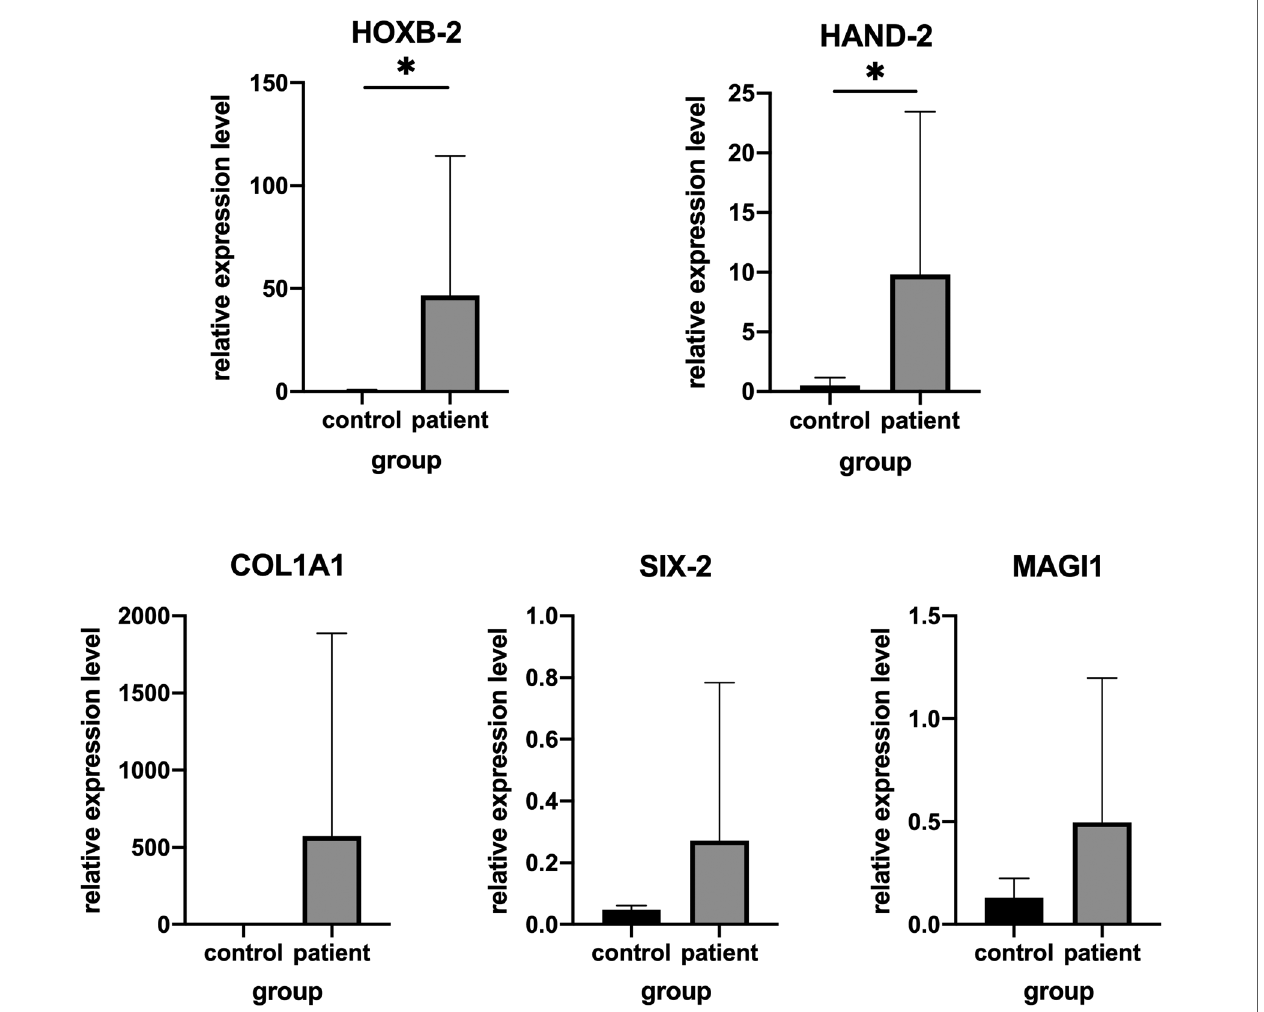
FIGURE 2 Validation of genes expression by real-time PCR in other patients and matched controls. ( A ) HAND2 , ( B ) HOXB2 , ( C ) COL1A1 , ( D ) MAGI1 and ( E ) SIX-2 .* P